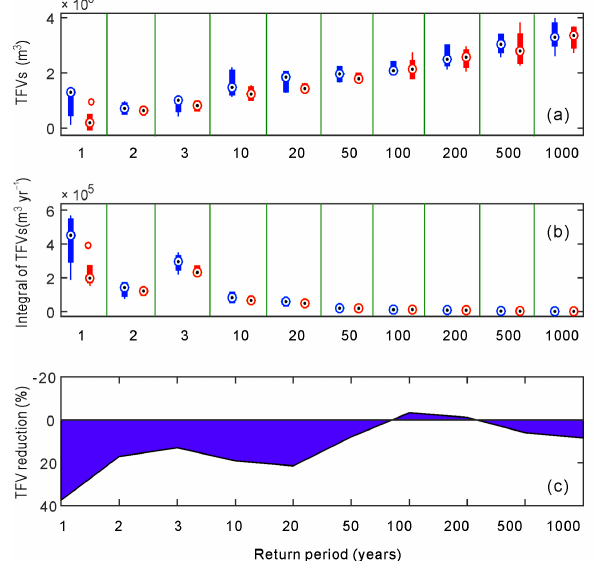
Figure 4. Comparison of (a) flood volume and (b) total TFVs (i.e. the piece-wise integral of flood volume versus the expected fre- quency with changes in precipitation intensity of various return pe- riods under RCP8.5, blue, and RCP2.6, red). Panel (c) shows the TFV reduction calculated as the percentage difference in TFVs un- der RCP2.6 compared to RCP8.5 (i.e. benefits of climate mitigation) at various return